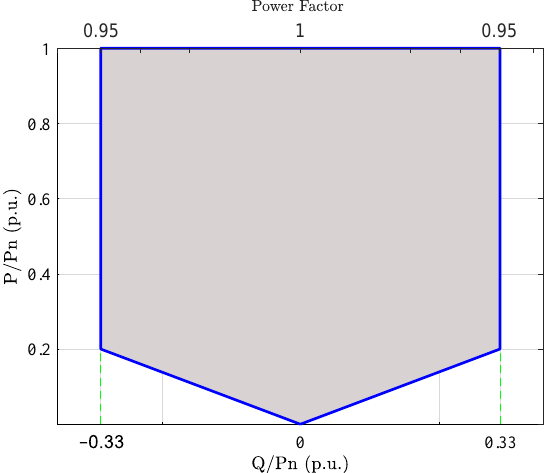
Figure 15. Range of reactive power generation/absorption at the power plant connection point. The region limited by the line in blue represents the area of reactive power regulation through voltage or power factor control during continuous voltage